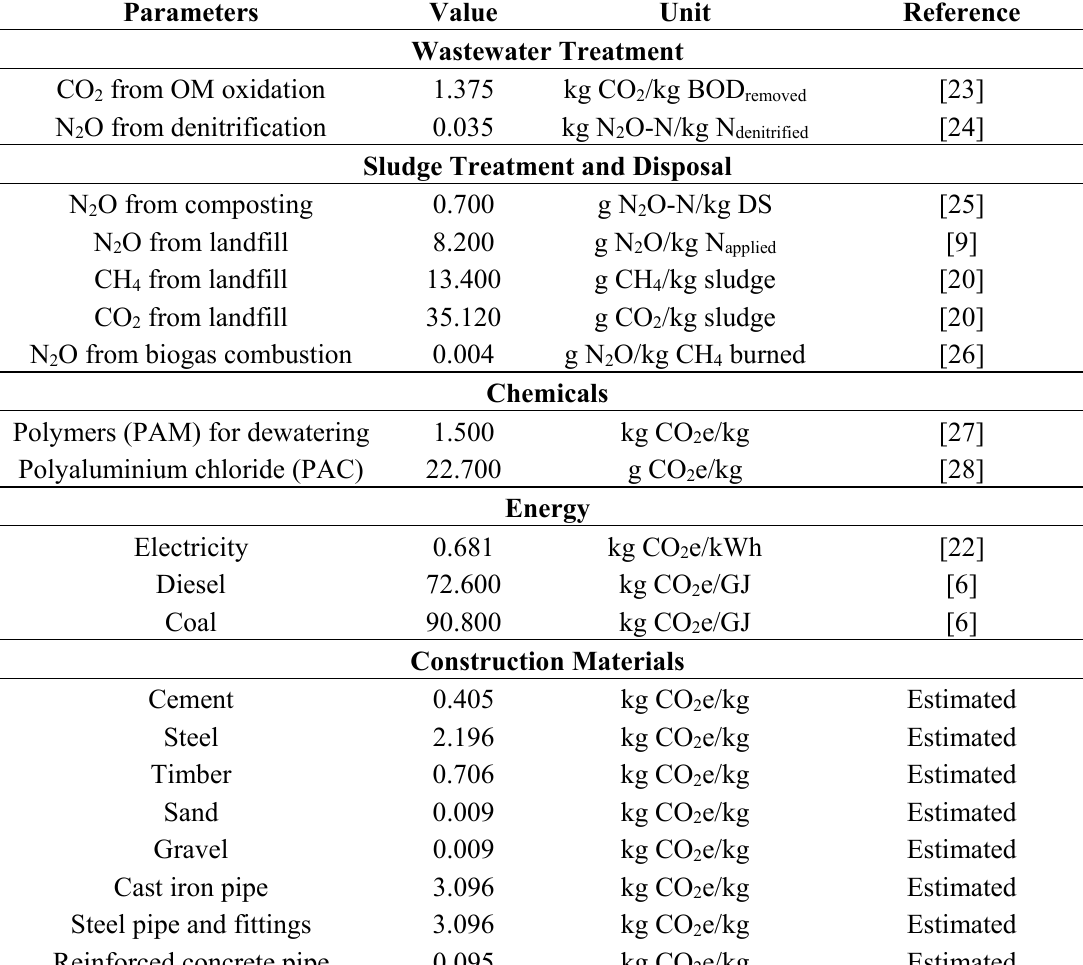
Table 2. Emission factors for greenhouse gas (GHG) calculation used in this